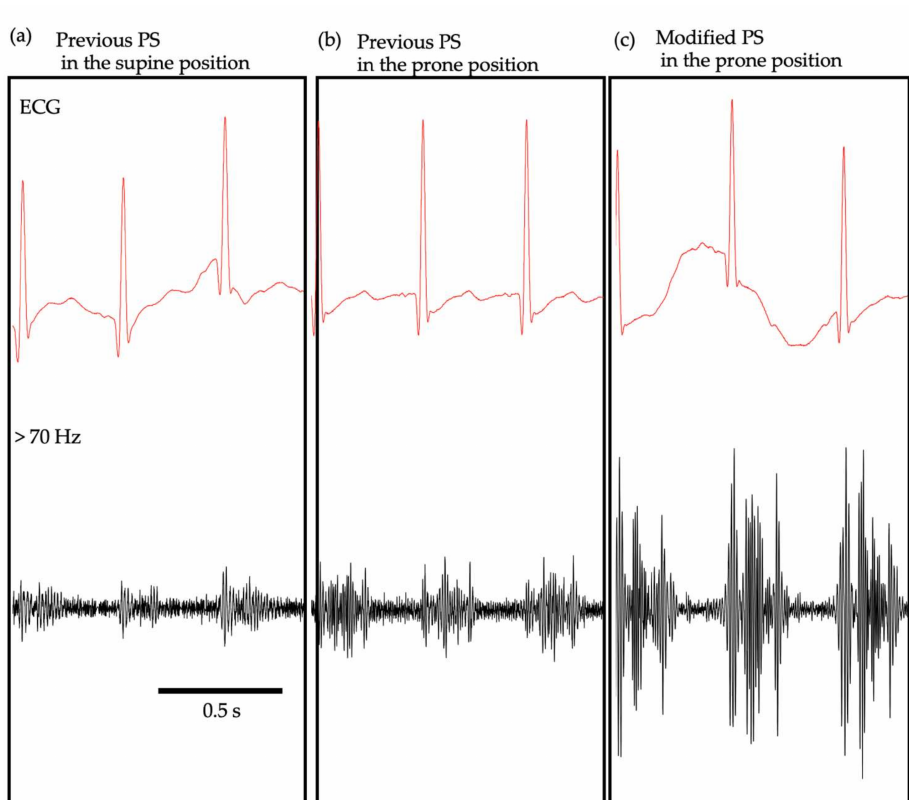
Figure 2. Comparison of heart sound signals and murmurs between the previous and modified PS. Simultaneous recording of ECG and the PS waveforms recorded with the previous PS in the supine ( a ) and prone ( b ) positions and the modified PS in the prone position ( c ). The PS waveforms were high-pass-filtered with a cut-off frequency of 70